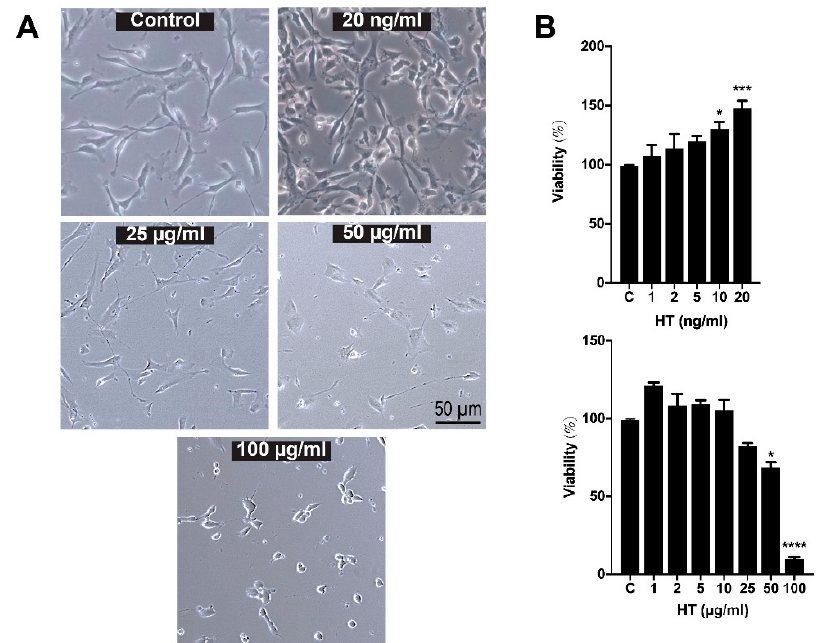
Figure 2. ( A ) Morphology of hSC after 24-h treatment with hydroxytyrosol (HT). Hydroxytyrosol does not alter the morphology of hSCs after 24 h of treatment, except at concentrations of 50 and 100 µ g / mL whereby hSCs started to shrink. ( B ) Cell viability assay of hSC after 24 h of treatment with HT. One-way ANOVA and post hoc Tukey test revealed a significant increase in hSC proliferation following treatment with HT at concentrations of 10 and 20 ng / mL when compared to the control group. HT is significantly toxic to hSCs at 50 and 100 µ g / mL. p -value * < 0.05, *** < 0.001, **** < 0.0001 vs. control.